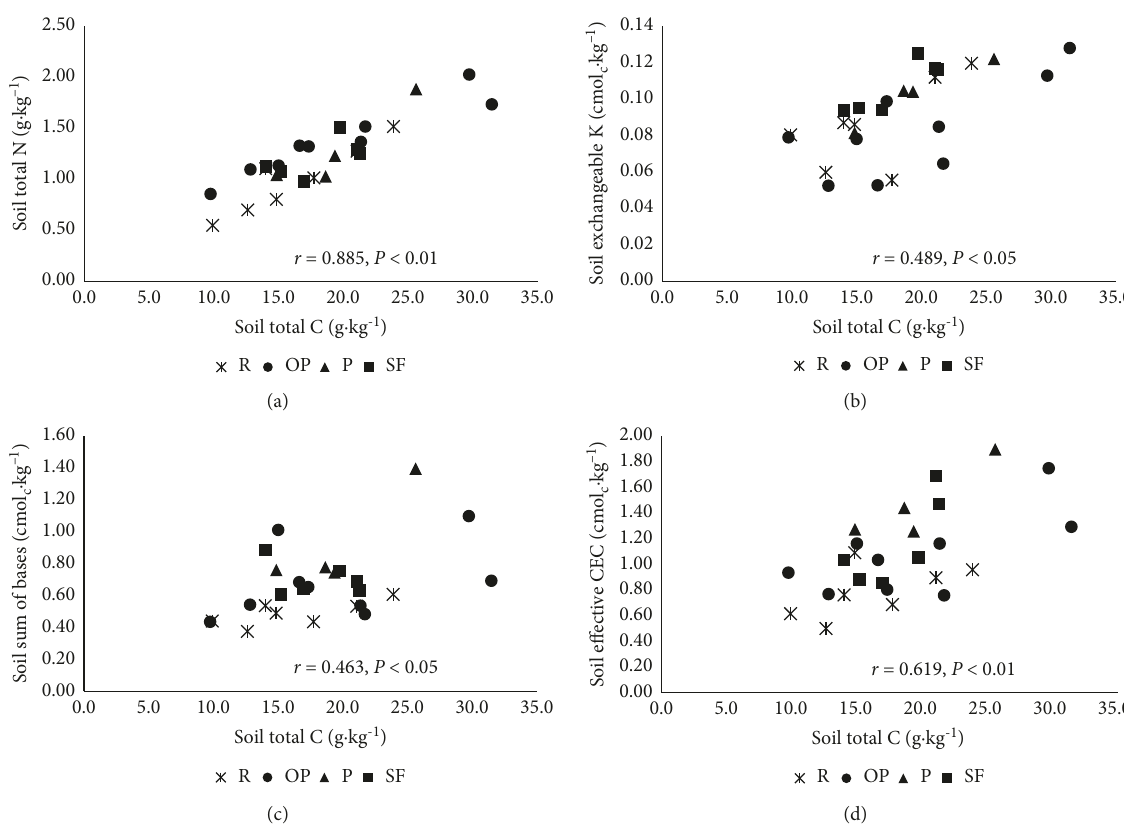
Figure 2: Relationships between soil total C and soil total N, soil exchangeable K, soil sum of bases, and soil effective CEC at the surface soil